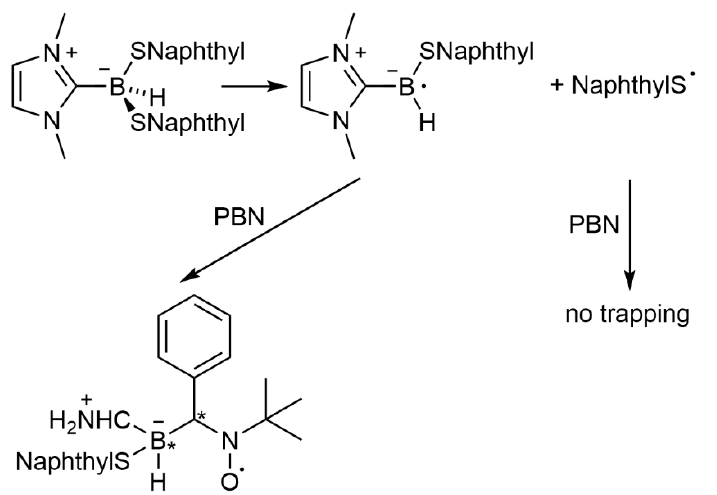
Figure 8. PBN spin adducts derived from an NHC-boryl bis-sulfide photopolymerization initiator [41]. The two stereogenic centres in the spin adduct are identified with asterisks.